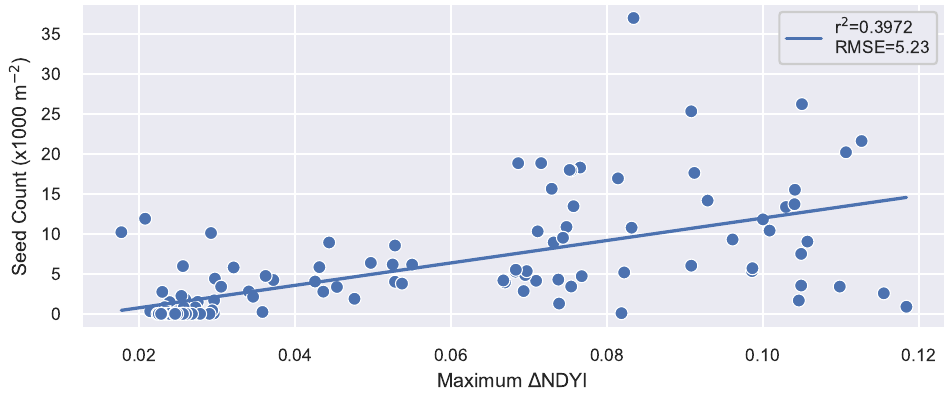
Figure 5. The relationship between the maximum ∆ NDYI (spring 2018) and the number of seeds collected from seed traps in the permanent trap network (autumn/winter 2019) for the 2018/2019 masting season. The locations are filtered to exclude those with fewer than eight valid satellite